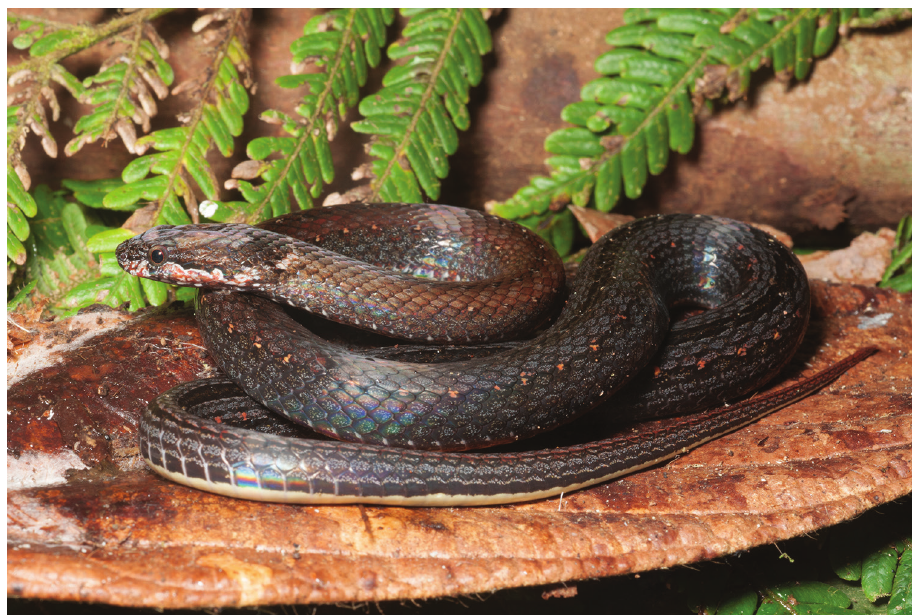
Figure 66. Cyclocorus nuchalis taylori (KU 334469) from May-Impit, Mt. Hilong-hilong, Municipality of Remedios T. Romualdez, Agusan del Norte Province. Photo: